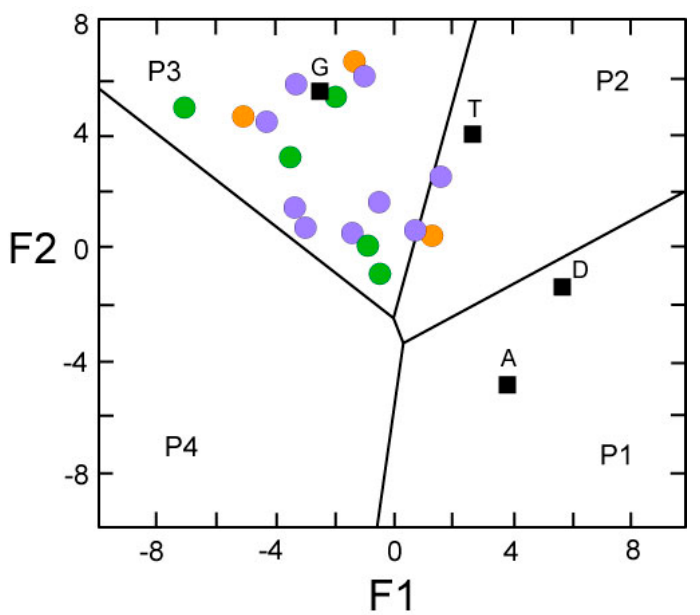
Figure 7. Plot of biotite gneiss from the New Jersey Highlands, and kornerupine-bearing variants of the gneiss from Ringwood and Mase Mountain, on a tectonic discrimination diagram [29]. F1 versus F2 calculated from discriminant function analysis using Al 2 O 3 , TiO 2 , Fe 2 O 3T , MgO, CaO, Na 2 O, and K 2 O. Fields: P1, Mafic Igneous Provenance; P2, Intermediate Igneous Provenance; P3, Felsic Igneous Provenance; P4, Quartzose Sedimentary Provenance. Average compositions of granite (G), tonalite (T), diorite (D), and amphibolite (A) are from the New Jersey Highlands [15]. Symbols as in Figure 5.